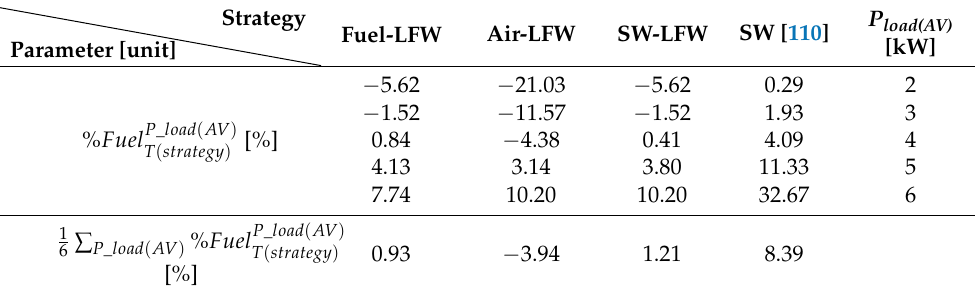
Table 9. Percent of fuel economy for the second load profile in case of k eff = 25 and P ref = 4.5 kW. Strategy Fuel-LFW Parameter [unit]